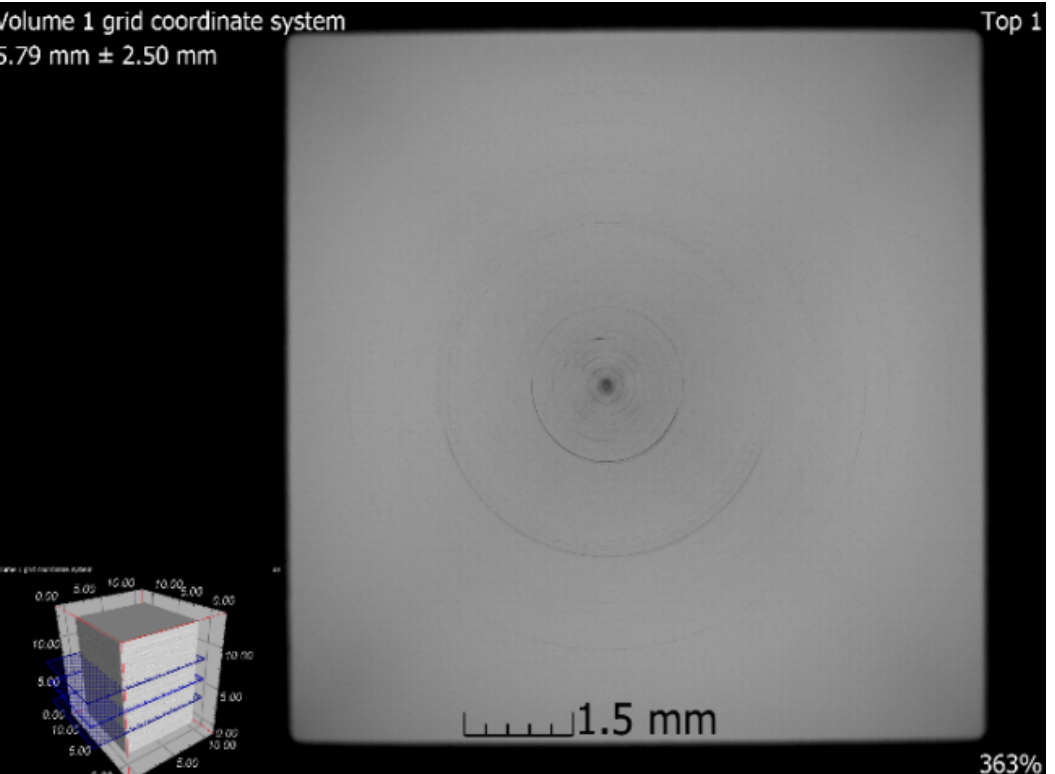
Figure 18. Tomographic CT sections of sample 5 after SLM + HIP_2 (XY plane).